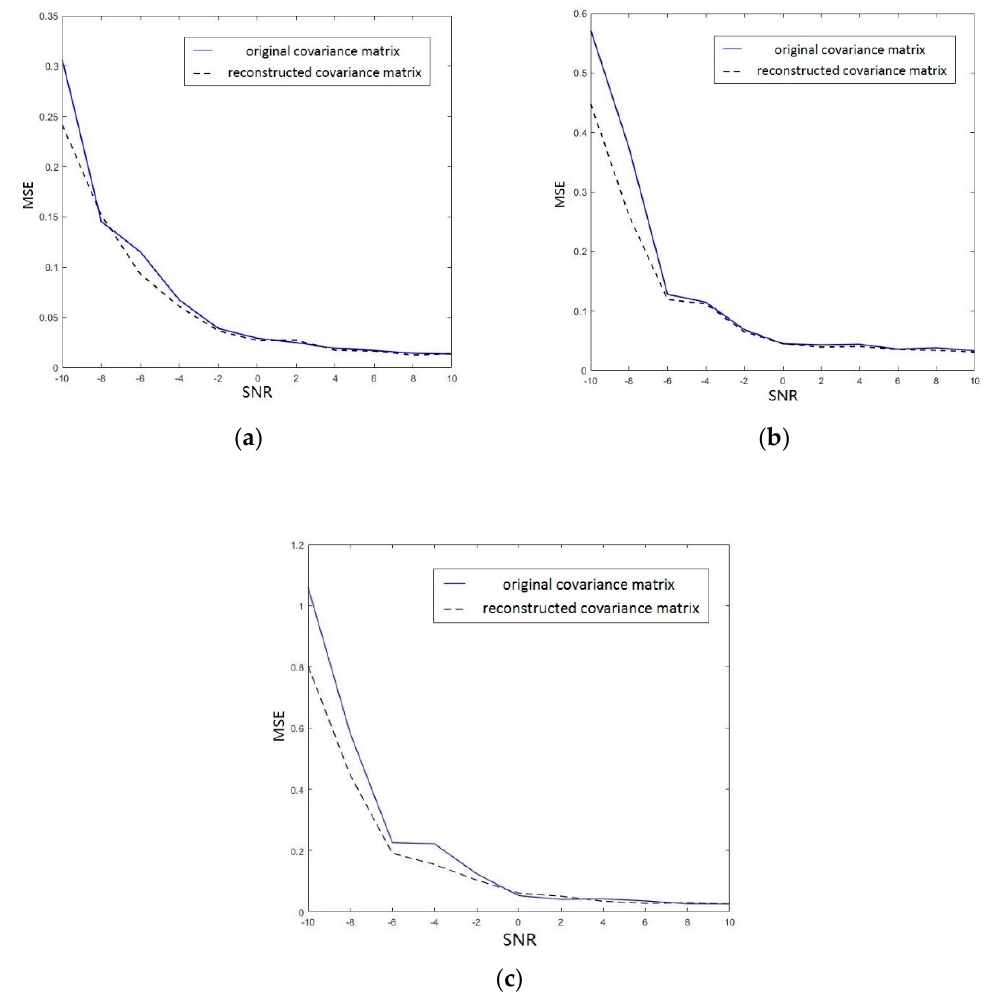
Figure 5. MSEs of the original covariance matrix R x and the reconstructed covariance matrix R xx in the environment contained noise and reverberation. ( a ) the sound reflection coefficient is 0.15 (RT60 = 100 ms); ( b ) the sound reflection coefficient is 0.2; and ( c ) the sound reflection coefficient is 0.25.